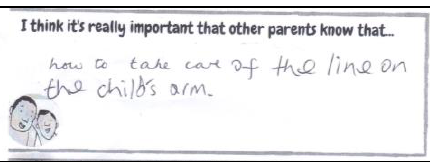
Figure 5. An example of a ‘ handwritten ’ response .